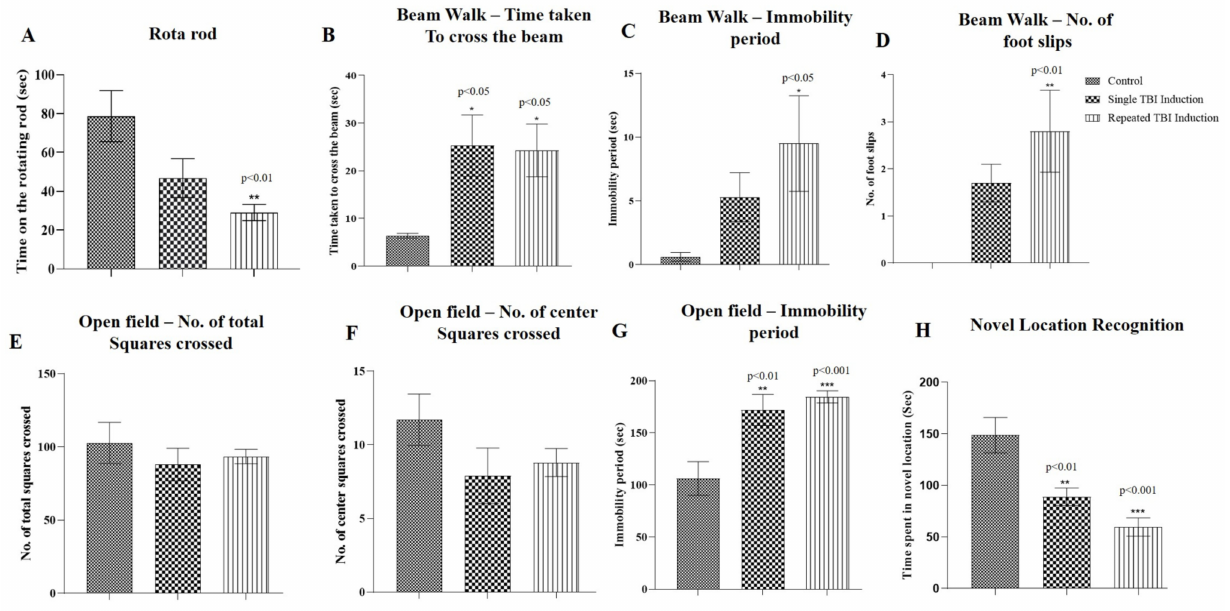
Figure 3. Effect of traumatic brain injury (TBI) on functional outcomes following single and repeated TBI induction in mice. Motor function was assessed using rota rod ( A ), beam walk ( B – D ) and open field ( E – G ) tests and cognitive function was assessed using novel location recognition tests in TBI mice. Bar graphs represents ( A ) time spent by the mice on the rotating rod, ( B ) time taken by the mice to cross the beam, ( C ) immobility period on the beam, ( D ) number of foot slips while walking on the beam, ( E ) number of total squares crossed in the open field, ( F ) number of center squares crossed, ( G ) immobility period in the open field and ( H ) time spent by the mice in the novel location. Values were expressed as mean ± SEM; n = 10; mean differences between the groups were analyzed using one way ANOVA followed by Tukey’s multiple comparison test as post hoc in Graphpad prism software (v 8.0); *, ** and *** indicate p < 0.05, 0.01 and 0.001, respectively vs. control